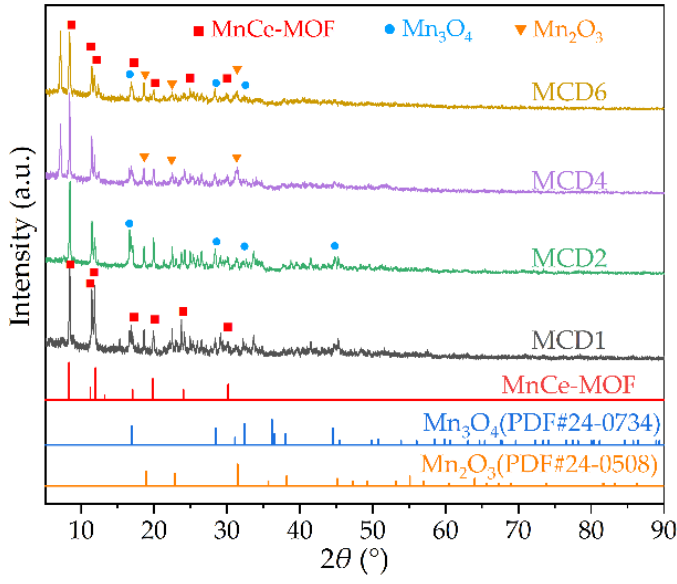
Figure 1. PXRD pattern of MCDx